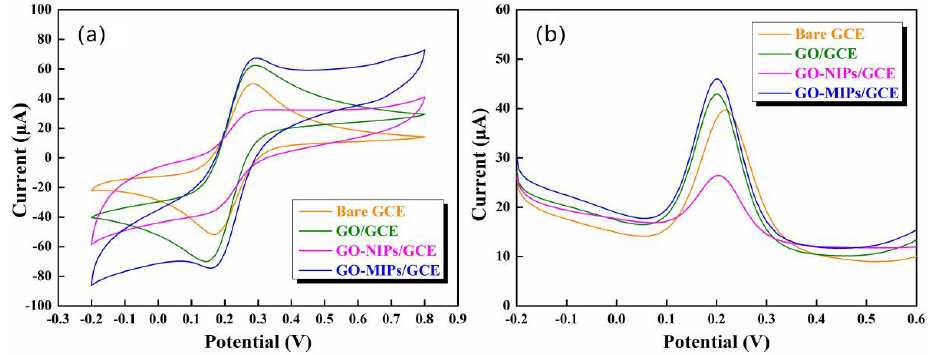
Figure 7. CV curves ( a ) and DPV curves ( b ) of bare GCE, GO/GCE, GO-NIPs/GCE, and GO-MIPs/GCE in a solution containing 5.0 mmol L − 1 of K 3 [Fe(CN) 6 ] and 0.1 mol L − 1 KCl.